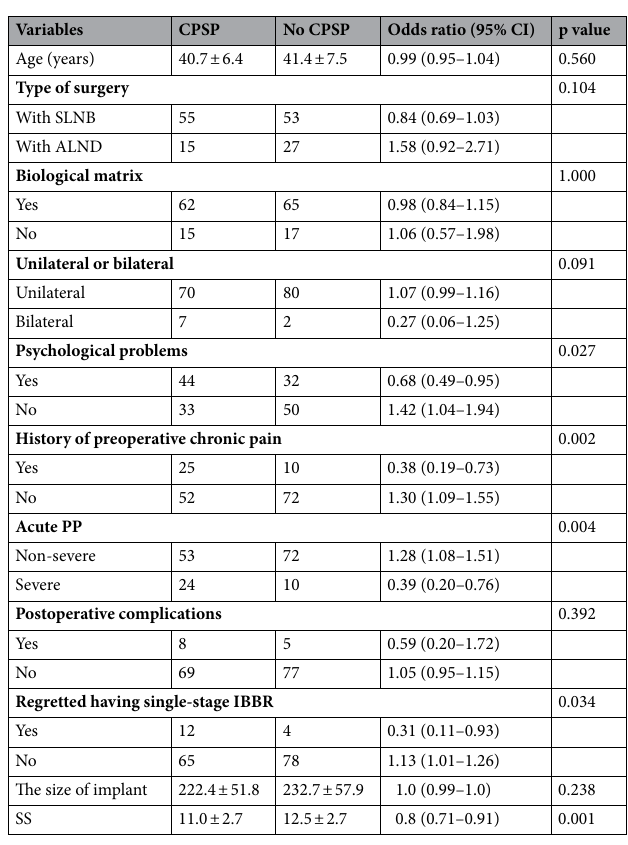
Table 3. The univariate analysis of risk factors for CPSP. CPSP chronic post-surgical pain, ALND axillary lymph node dissection, SNLB sentinel lymph node biopsy, PP postoperative pain, IBBR implant-based breast reconstruction, SS satisfaction